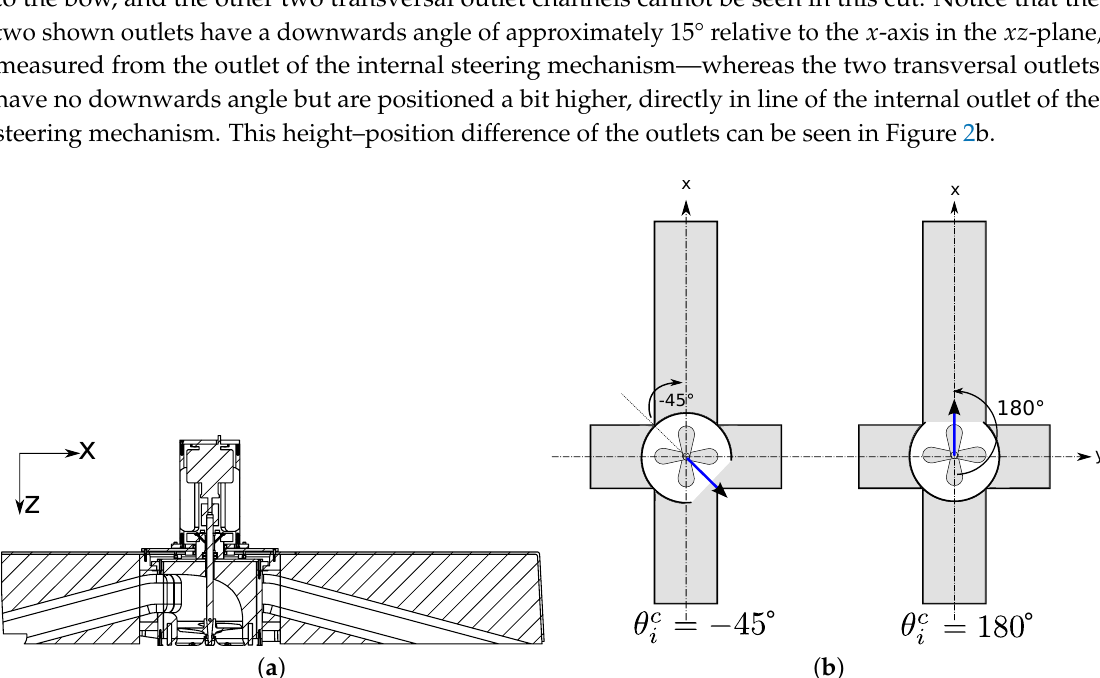
= − 45° and = 180°, adapted i